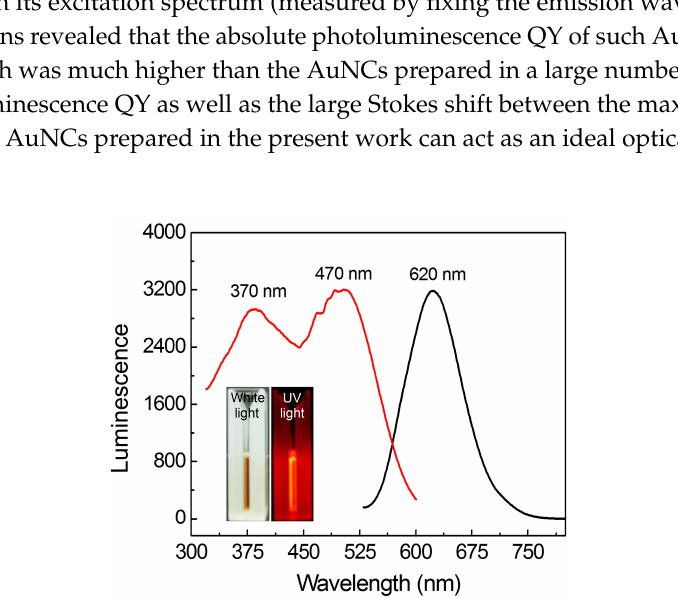
Figure 2. AFM image and the corresponding height measurement of the as-prepared AuNCs.